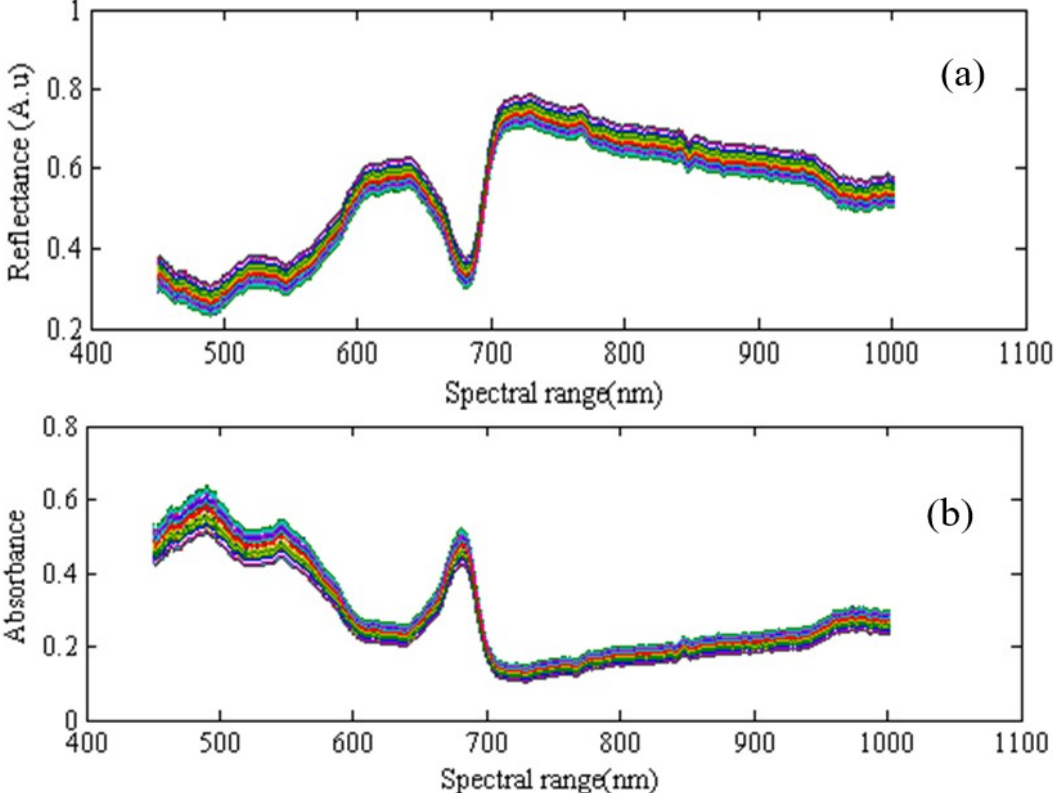
Figure 2. Spectral diagrams of several samples tested. ( a ): Reflectance spectrum of different samples. ( b ): Spectral graphs transferred from the reflectance spectrum to the absorption spectrum.